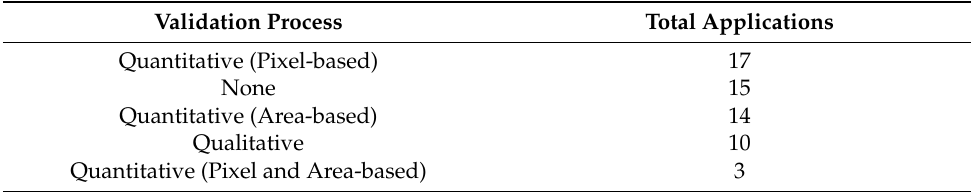
Figure 8. Application trends (a); cumulative application trends (b). Table 3. Validation processes reported in the selected